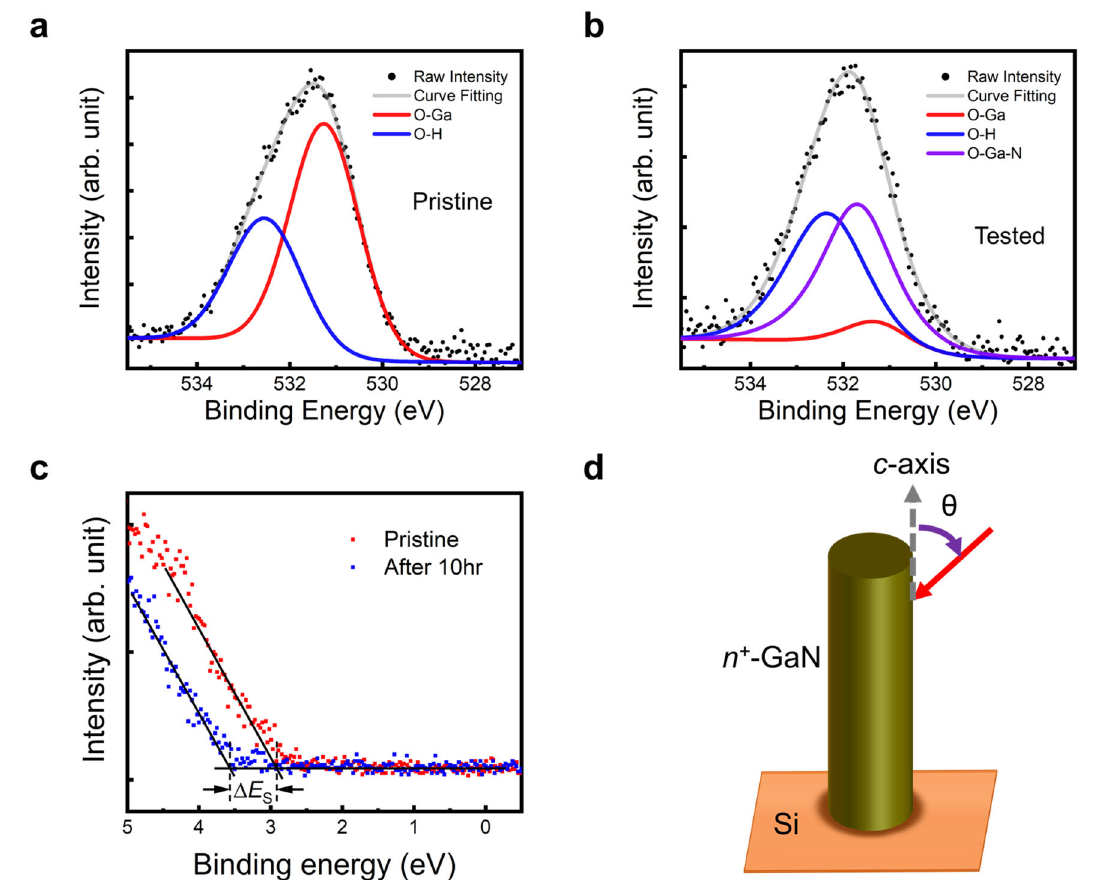
Fig.3|X-rayphotoelectronspectroscopyofthephotocathodebeforeandafter stability measurements. a , b XPS O 1s spectra of the n + -GaN nanowires/Si pho- tocathodeas-grown( a )andtested( b )underconditionsdescribedinthecaptionof Fig. 2, taken with the incident angle θ =60 (cid:1) . The de fi nition of the angle θ is sche- matically shown in ( d ). The as-grown photoelectrode ( a ) showed deconvoluted peaks at 531.3eV and 532.6eV for O-Ga (red curve) and O-H (blue curve), respec- tively. After 10hours of chronoamperometry (CA) ( b ), an additional deconvoluted peak at 531.6eV corresponding to gallium oxynitride species (violet curve)